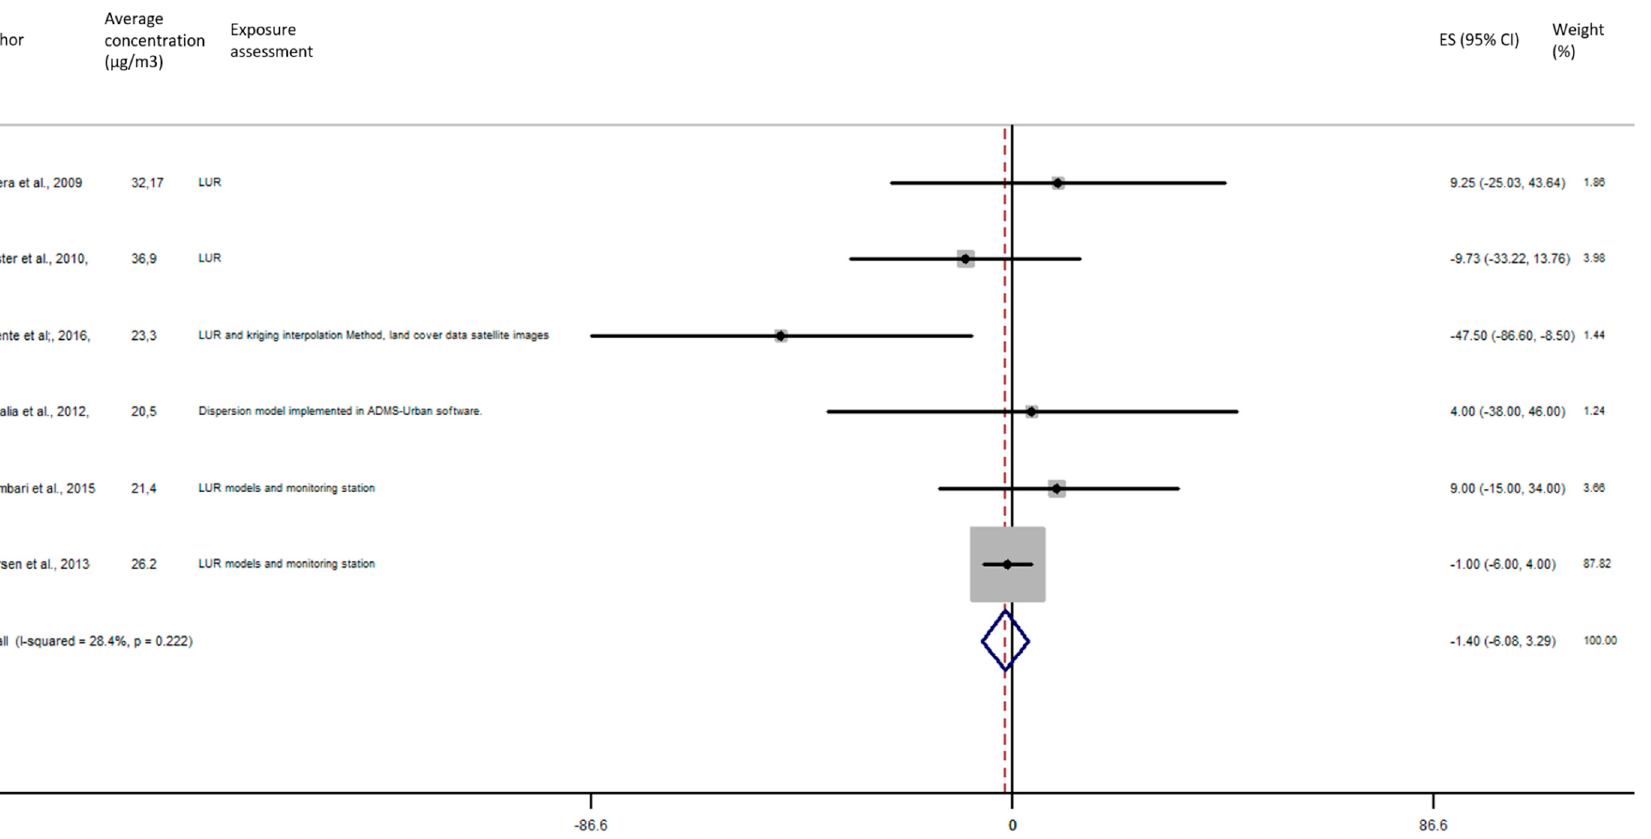
Figure 8. Association between birth weight and NO 2 exposure during the entire pregnancy.